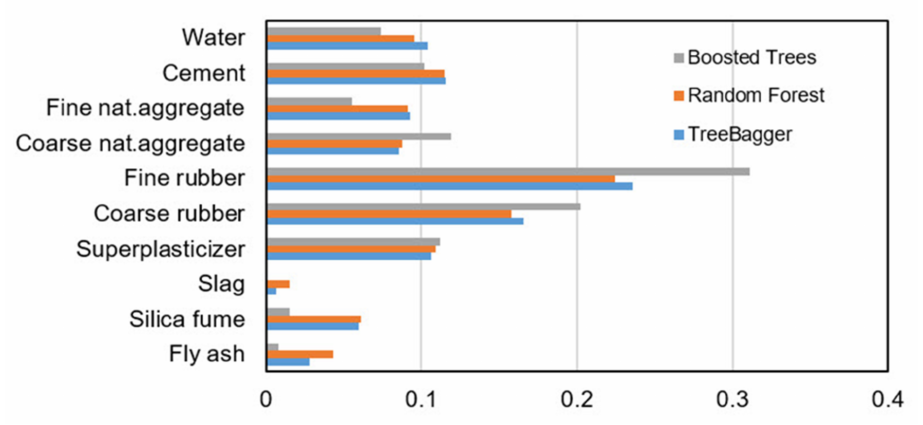
Figure 13. Significance of individual variables in the ensemble model when applying the Bag- ging method.